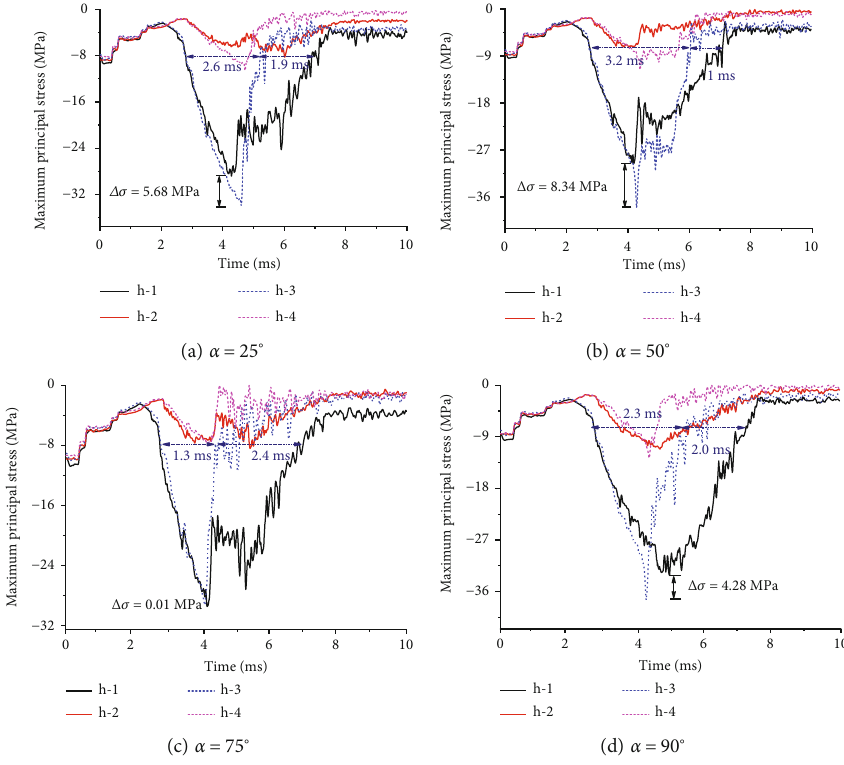
Figure 9: h -1 ~ h -4 maximum principal stress change.